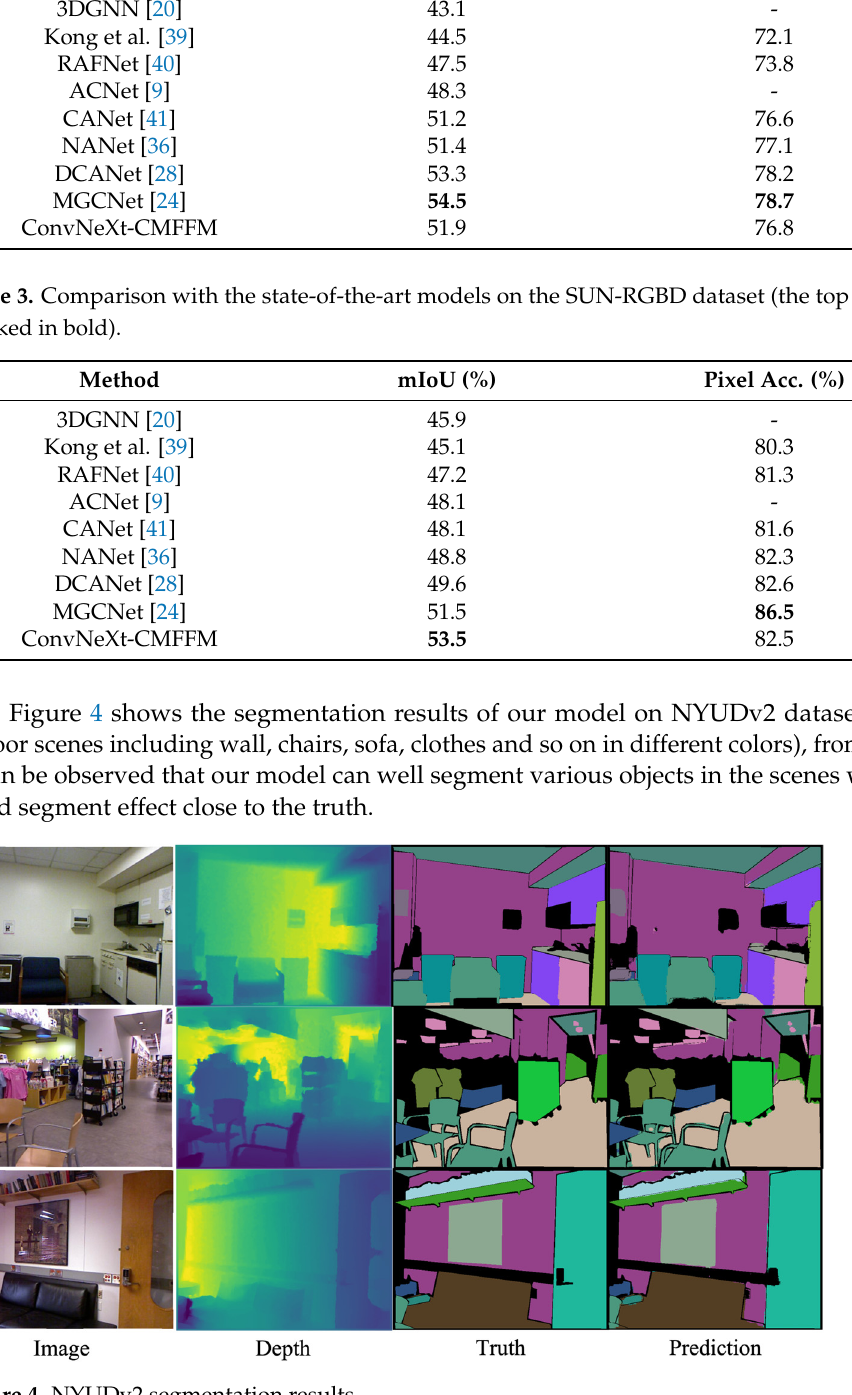
Figure 4. NYUDv2 segmentation